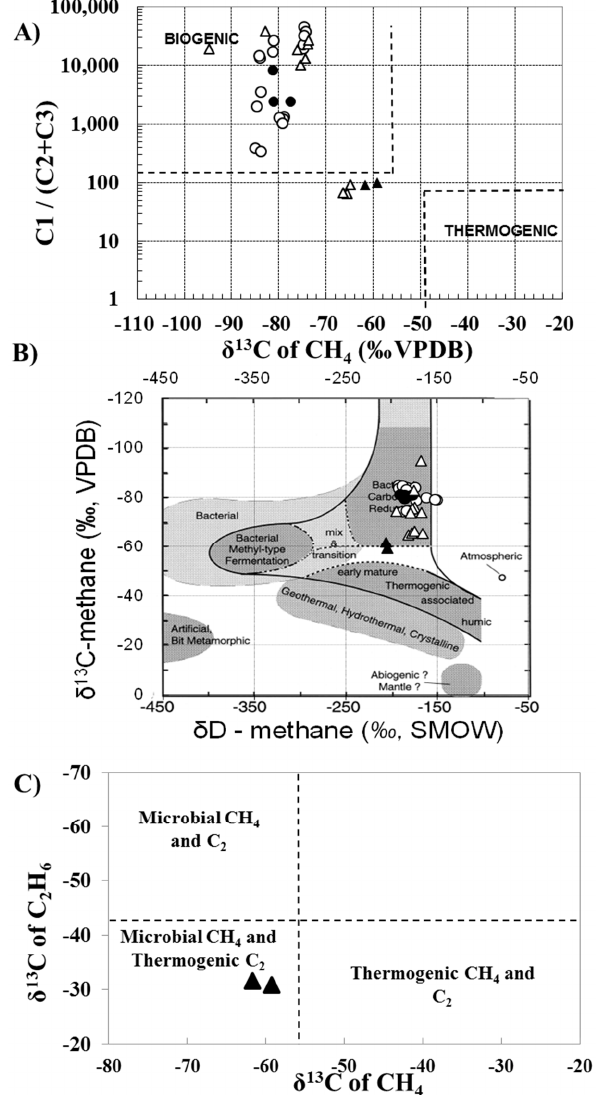
Figure 2. Diagram showing the relationship between molecular and isotopic compositions of hydrate-bound, free and dissolved gases in sediments of the Amazon fan and adjacent continental slope, based on the classifications of Whiticar [35], Milkov [39] and Taylor et al. [40]. ( A ) Chemical and isotopic compositions of free gas from sediments using C1/(C2+C3) versus 13 C plot; ( B ) Chemical and isotopic compositions of free gas from sediments using 13 C-CH 4 versus D-CH 4 ; ( C ) Chemical and isotopic compositions of free gas from sediments using 13 C 2 H 6 versus 13 CH 4 . Open and solid circles indicate hydrate-bound gases, and dissolved and free gases in pore water at the Amazon fan area, respectively, whereas open and solid triangles indicate hydrate-bound, free and dissolved gases in the adjacent continental slope study area northeast of the Amazon fan, respectively. The results of δ 13 C-CH 4 and gas composition (C1–C5 hydrocarbons) for gas hydrate were previously reported